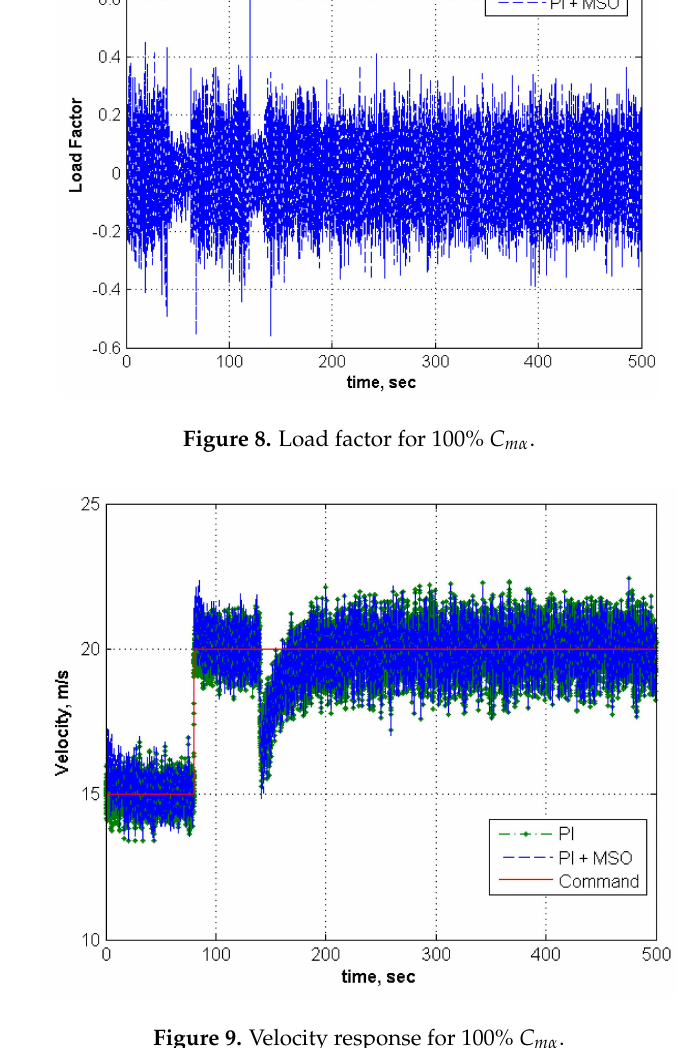
Figure 9. Velocity response for 100% C m α